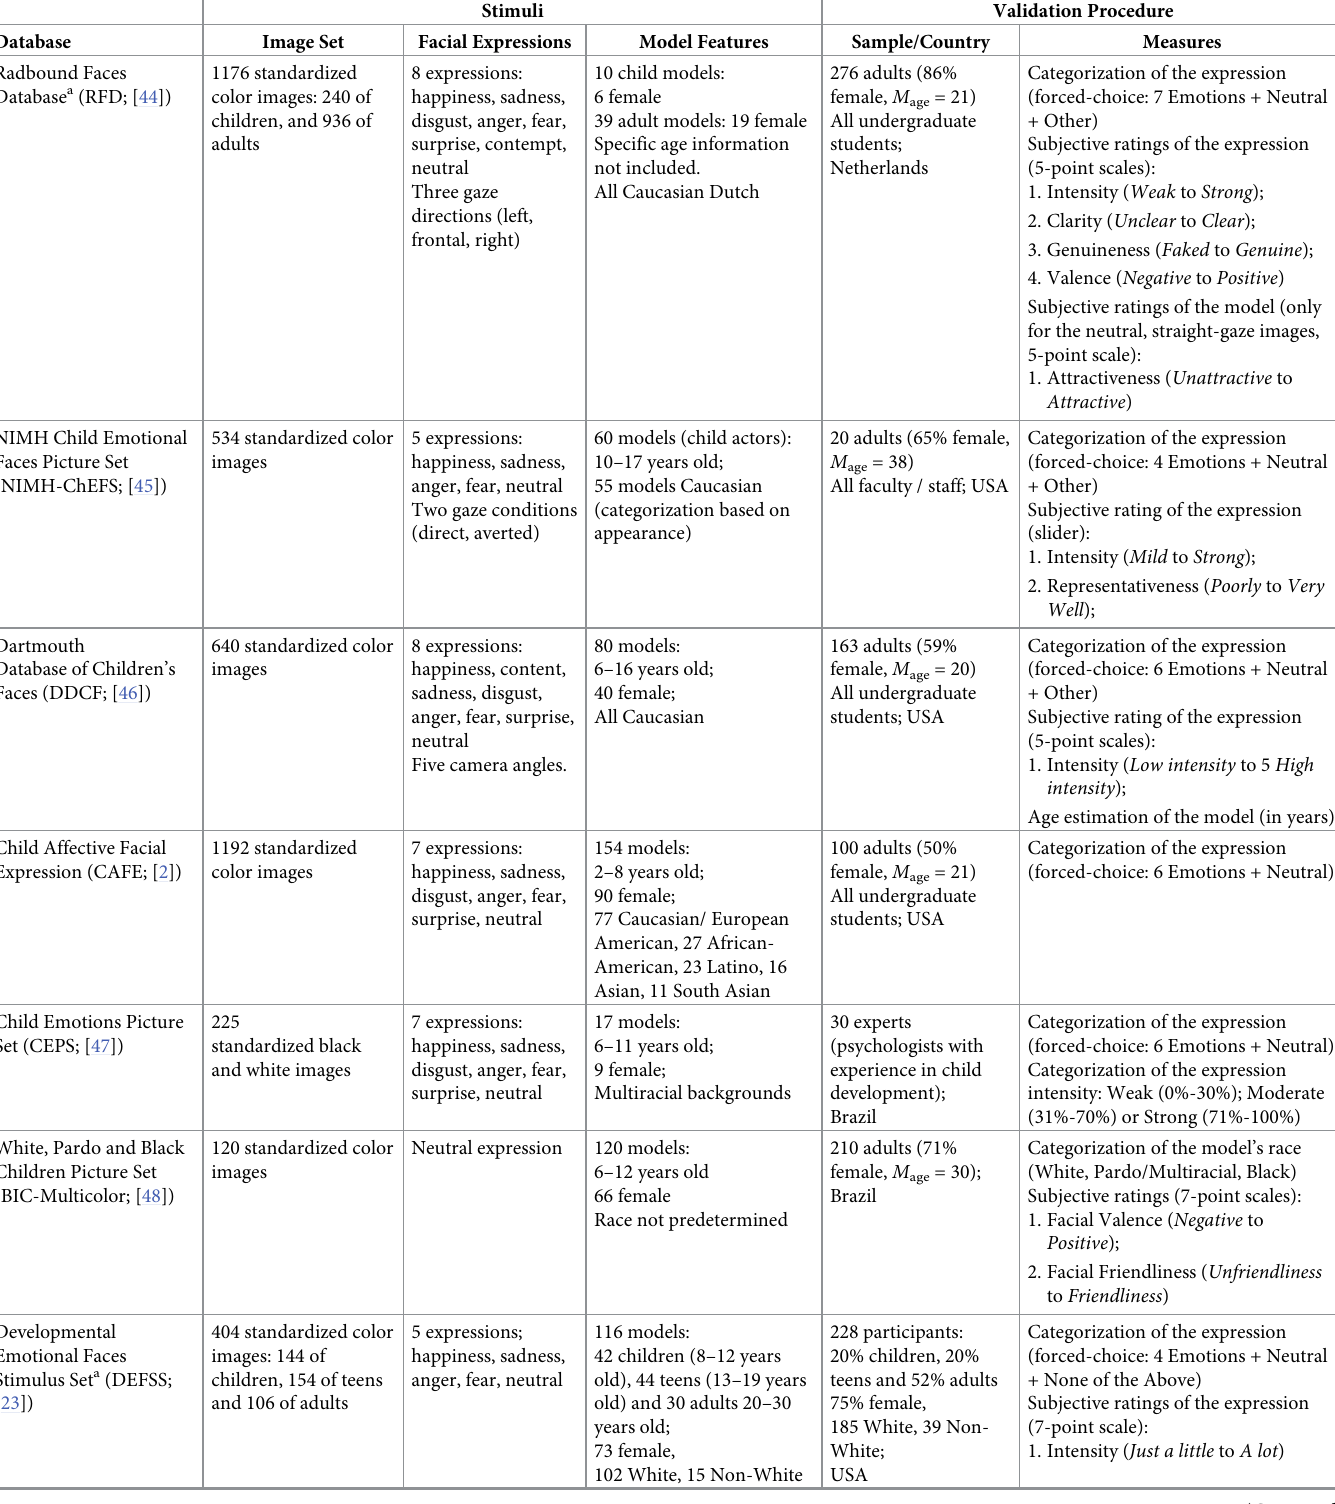
Table 1. Overview of children’s facial expressions